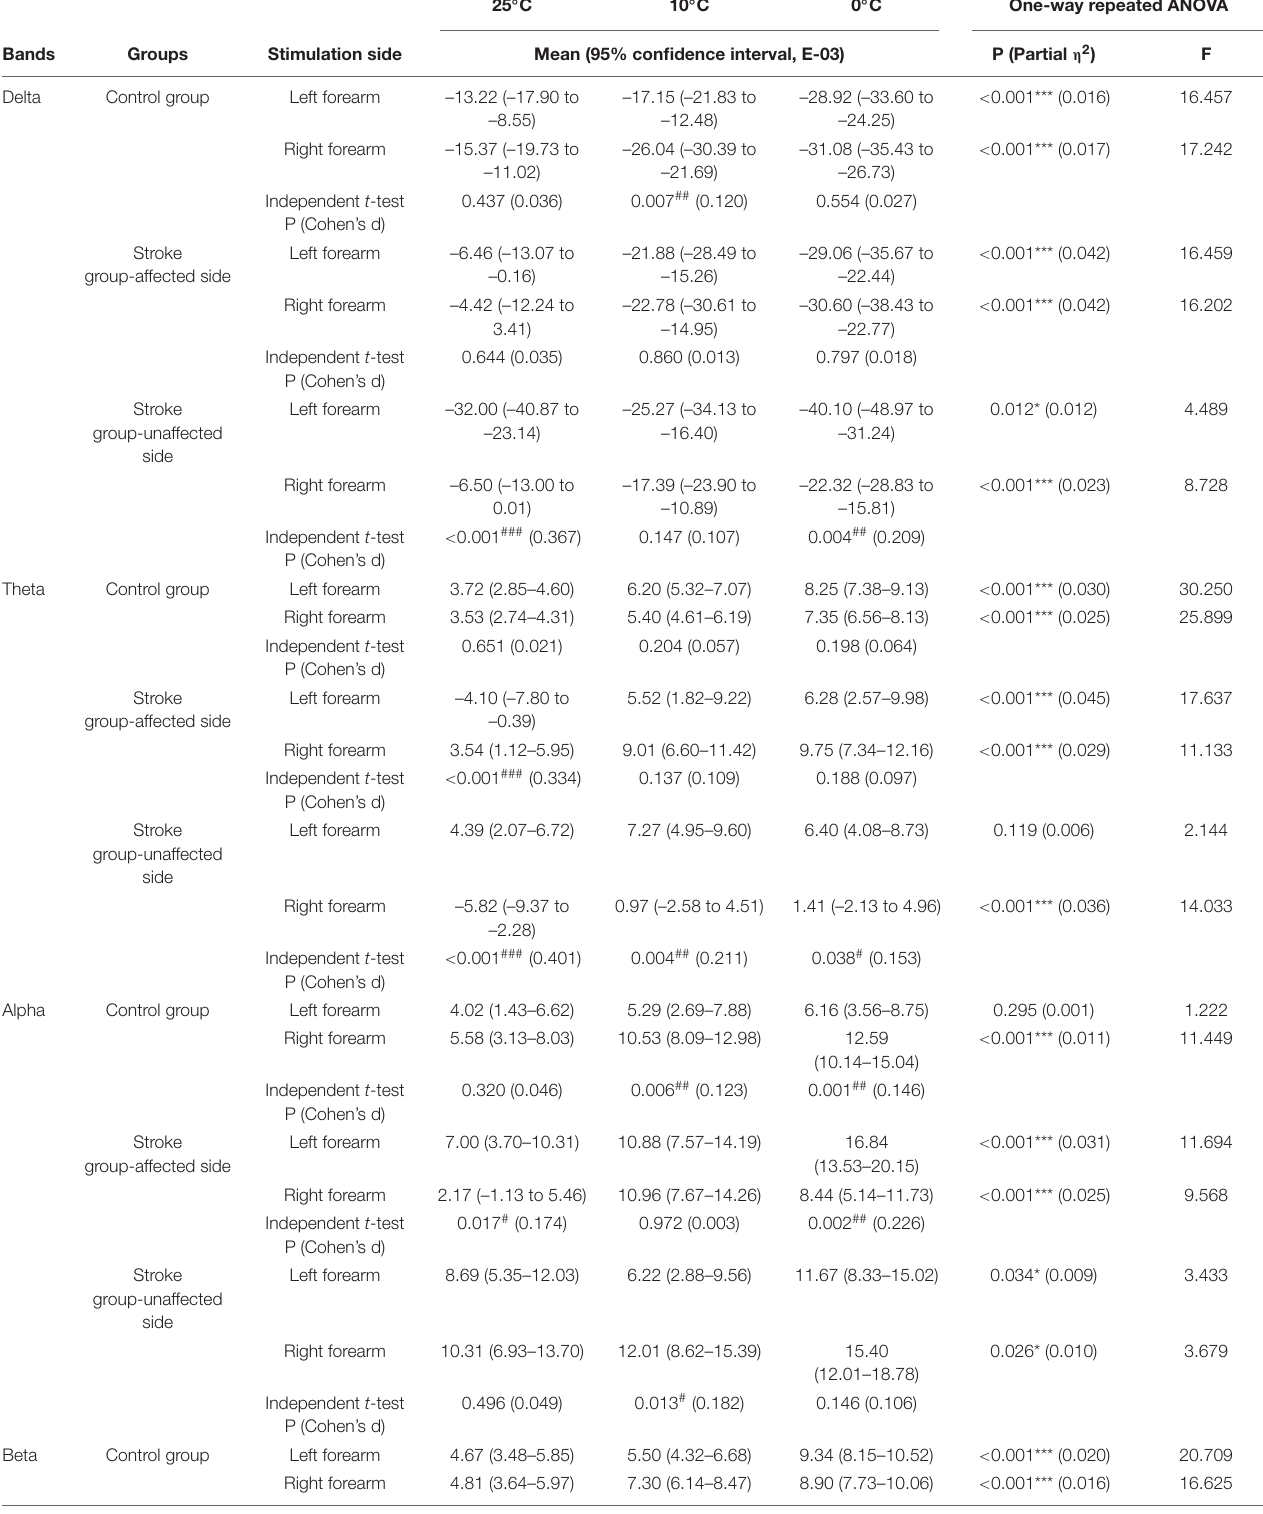
TABLE 3 | The whole brain relative spectral power of each non-painful cold stimuli for each group. 25 ◦ C 10 ◦ C One-way repeated